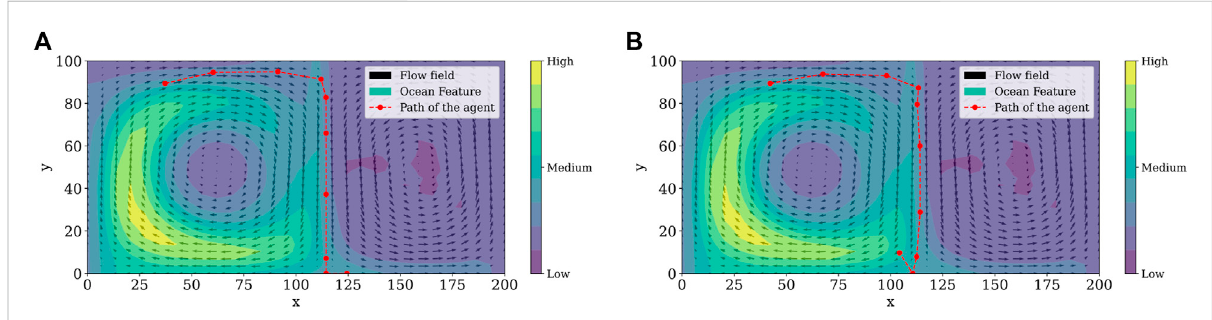
FIGURE 6 Path followed by the agent, double gyre fi eld to estimate the parameters described in Table 2 at different episodes (A) episode 3, (B) episode 7.